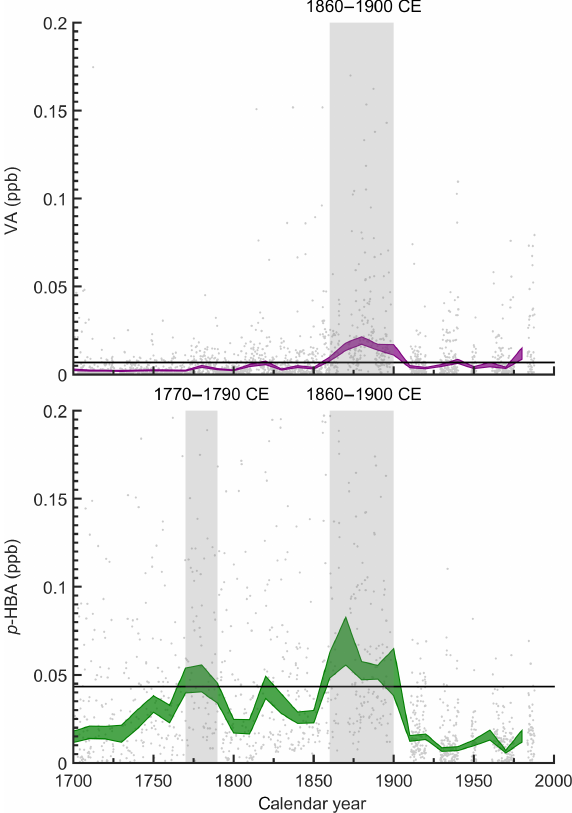
Figure 6. Akademii Nauk vanillic acid (top) and para - hydroxybenzoic acid (bottom) ice core records. Individual measure- ments are shown as gray points. The color-filled lines are expo- nentials of ± 1 standard errors of 10-year bin averages of the log- transformed data. The solid horizontal lines represent the 75th per- centile of each dataset (after 1700CE). The vertical gray shaded areas are periods of elevated vanillic acid or para -hydroxybenzoic acid, identified as periods when the bin-averaged data are in the up- per quartile of the transformed